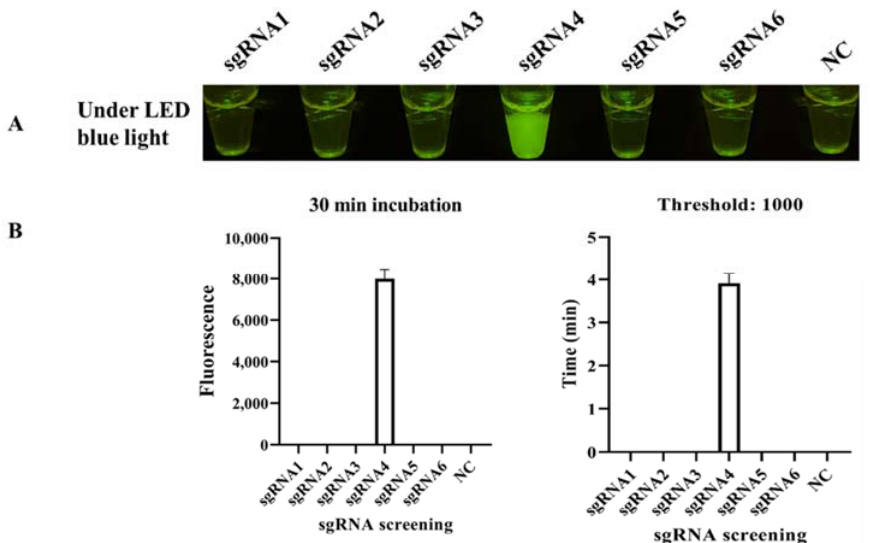
Figure 3. sgRNA screening. ( A ) Endpoint CRISPR/Cas12a for sgRNA screening. Six sgRNAs were designed based on the target DNA and used in CRISPR/Cas12a at 37 °C for 30 min, and sgRNA 4 worked well in the standard program, with strong fluorescent light under LED blue light. ( B ) Real-time CRISPR/Cas12a for sgRNA screening. The real-time monitoring was conducted in a CFX96 Touch Real-Time PCR Detection System for 30 min, and the endpoint fluorescence intensity and time with a fluorescence threshold of 1000 were monitored. Each experiment was repeated three times with similar results.